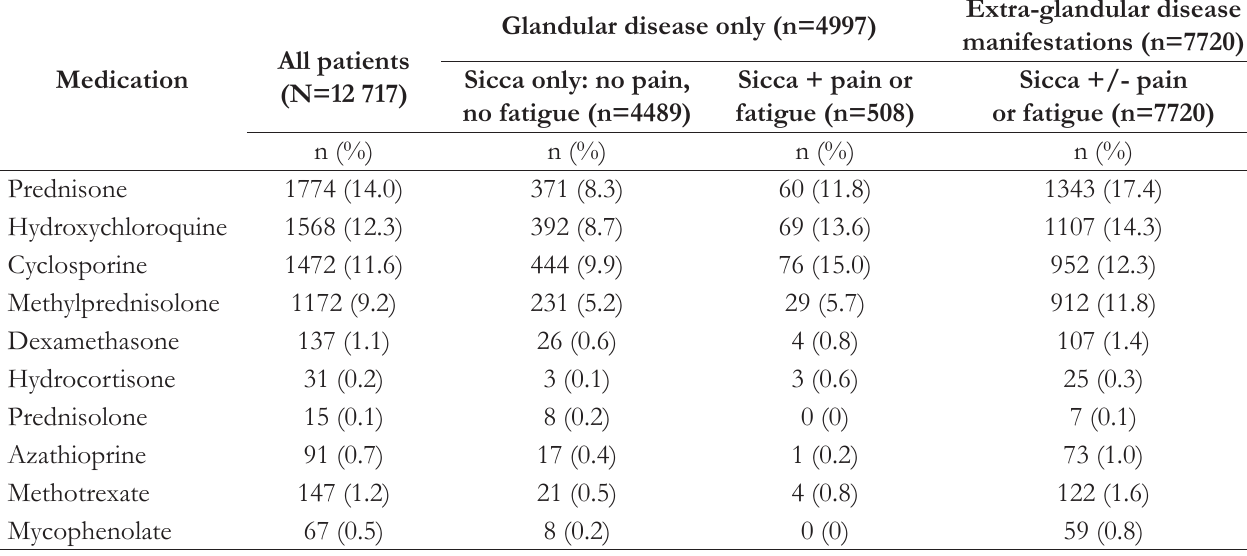
Table 3. Use of Pre-defined Medications of Interest in the Primary Cohort and by Disease Characterization